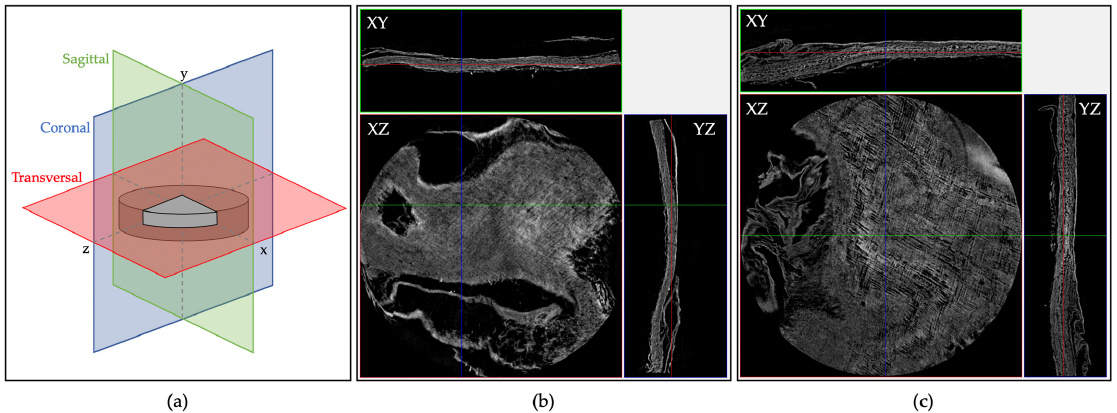
Figure 2. Coronal (Z-Y), sagittal (X-Y), and transversal (X-Z) view ( a ) of ST ( b ) and BT ( c ), where Z was the axis parallel to the fish backbone. Tilapia skin dermis can be observed in the transversal reconstruction. Sample size: 8 mm.